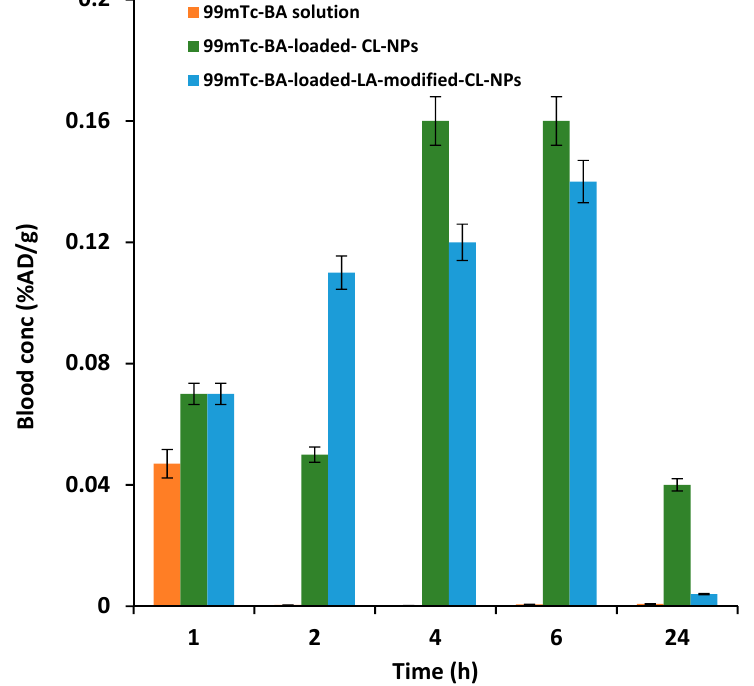
Figure 9. Mean ( ± SD) BA concentration in the blood following oral administration of radiolabeled 99m Tc-BA to mice.